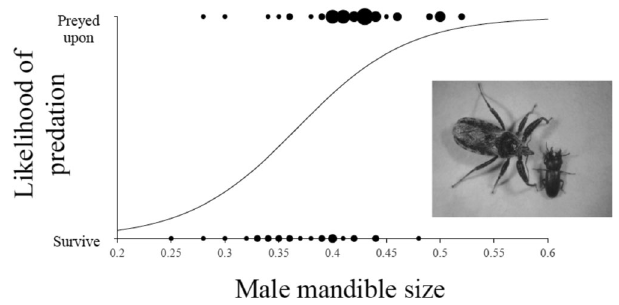
Fig. 3 The association between G. cornutus mandible size (mm) and likelihood of predation by A. venator . The graph shows that as mandible size increases so does the likelihood of predation. The curve is the fi tted frequency from the GLM with dot size representing numbers (1 – 6) of individual G. cornutus (i.e., larger dots = more beetles). Inset shows an A. venator about to attack a male G. cornutus . Note the size difference. Source data are provided as a Source Data fi